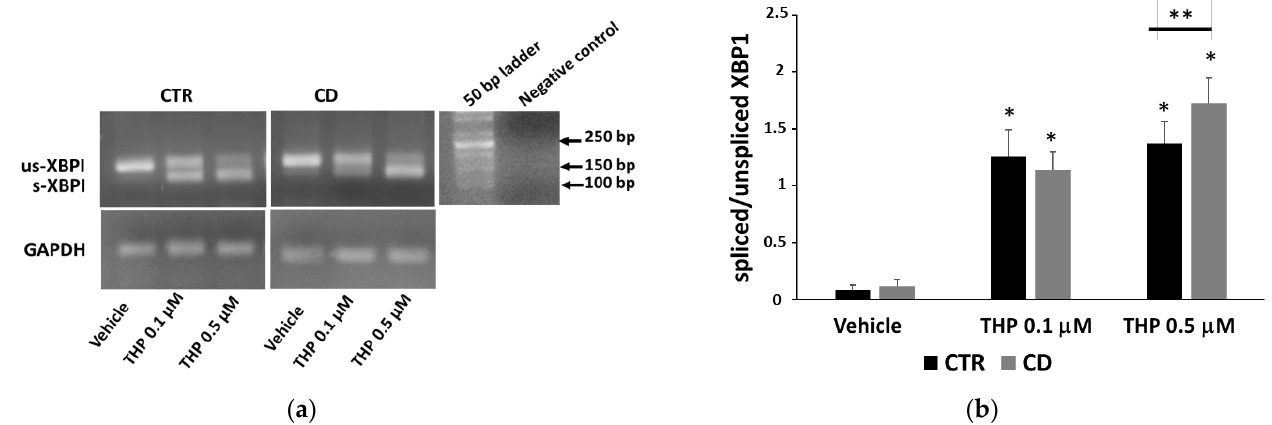
Figure 3. GRP78 expression. ( a ) Representative Western blot of the basal level of GRP78 in samples from three control and three celiac cultures. ( b ) Densitometric analyses of GRP78 basal levels, nor-malized with respect to GAPDH expression, relative to five controls and five celiac cultures. ( c ) Relative basal GRP78 mRNA levels measured in cultures from three control and three CD subjects. In panels ( a – c ), data are reported as mean ± SE. * p < 0.05 vs. controls (Student’s t -test for unpaired data). ( d ) Representative Western blot anti-GRP78 on samples from one control and one celiac culture in the presence of THP for 24 h. ( e ) Densitometric analyses relative to Western blot anti-GRP78 on samples from three control and three celiac cultures in the presence of THP. ( f , g ) Relative GRP78 mRNA levels measured in samples from three control and three celiac cultures in the presence of THP for 4 h and for 24 h, respectively. In ( e – g ) protein and mRNA levels are normalized with respect to GAPDH expression and expressed as variation with respect to the relative vehicle-treated sample. Data are reported as mean ± SE. * p < 0.05 vs. the respective vehicle.